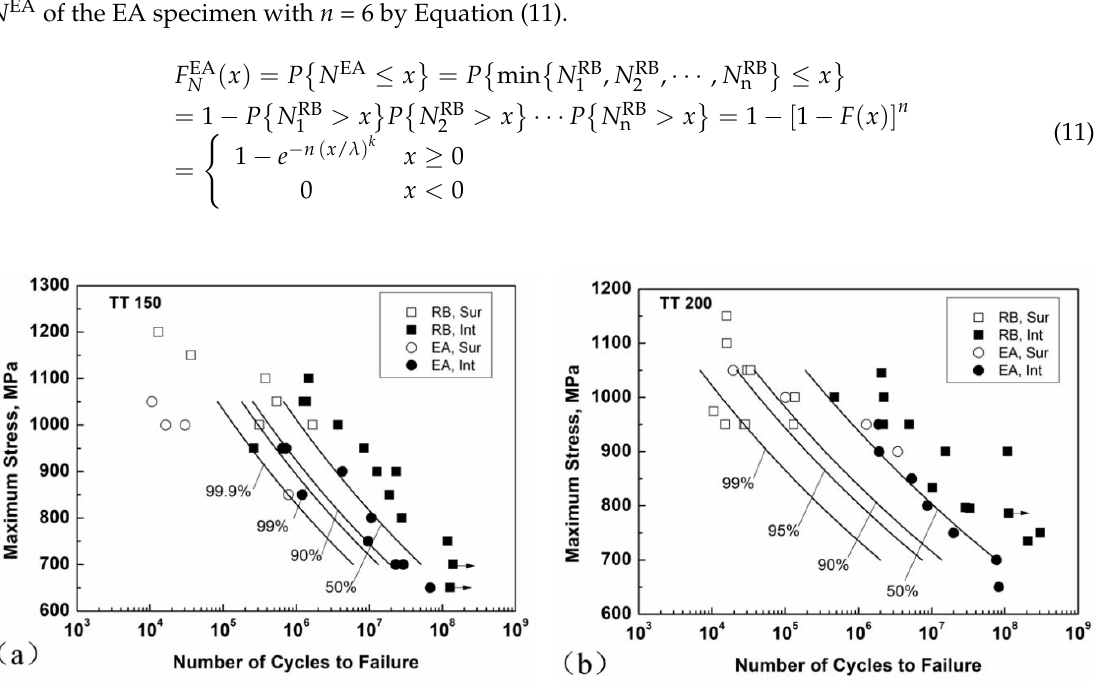
Figure 12. P-S-N (probability-stress-life) curves for the EA specimen ( V EA = 32.6 mm 3 ) derived from experimental data of the RB specimen ( V RB = 5.63 mm 3 ) for TT 150 ( a ); and TT 200 ( b ) together with tested S-N data.